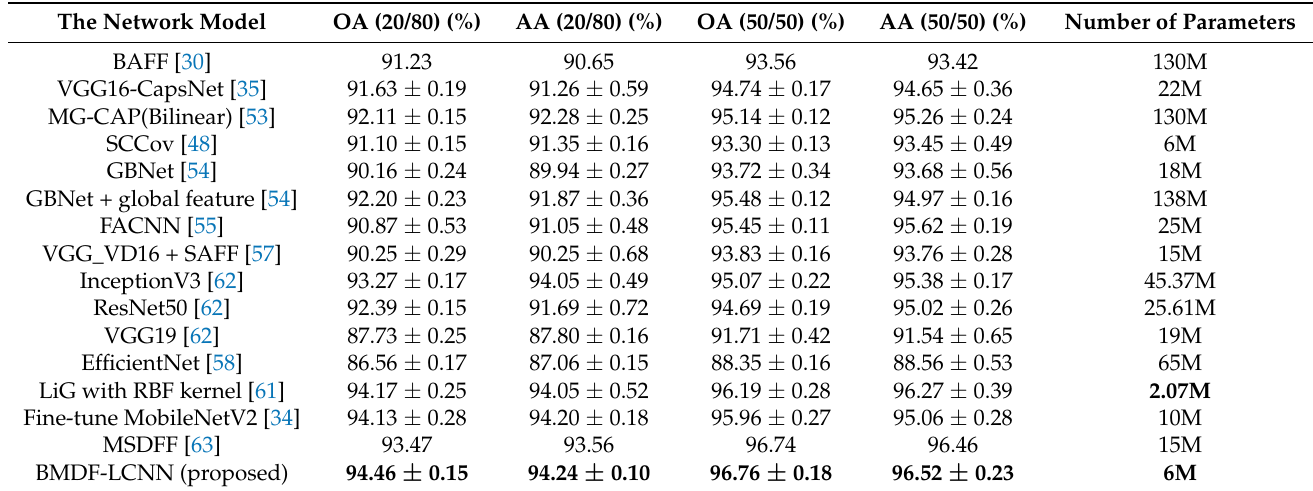
Table 6. Performance comparison of the proposed model with some advanced methods on AID datasets.